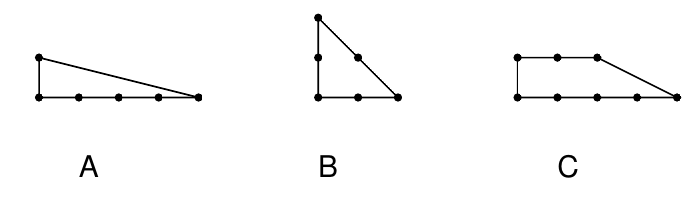
Figure 12 . Toric diagram of rank zero theory.